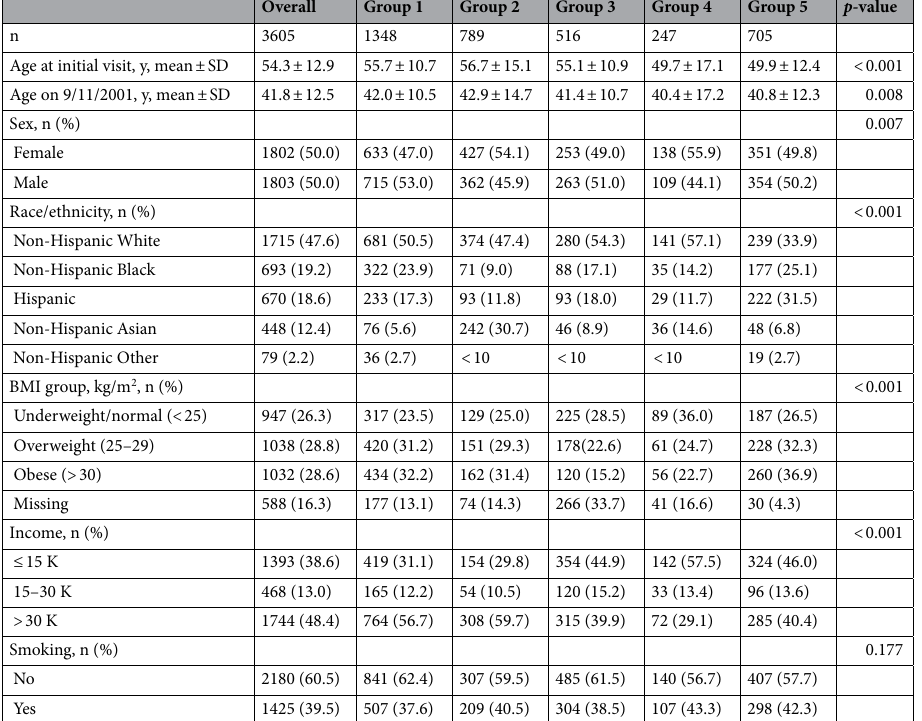
Table 1. Characteristics of patients in five latent exposure